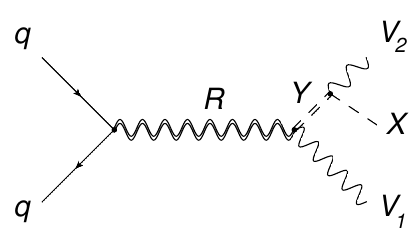
Figure 1 . Sample diagram for a R ! V 1 Y ! V 1 V 2 X triboson signal.